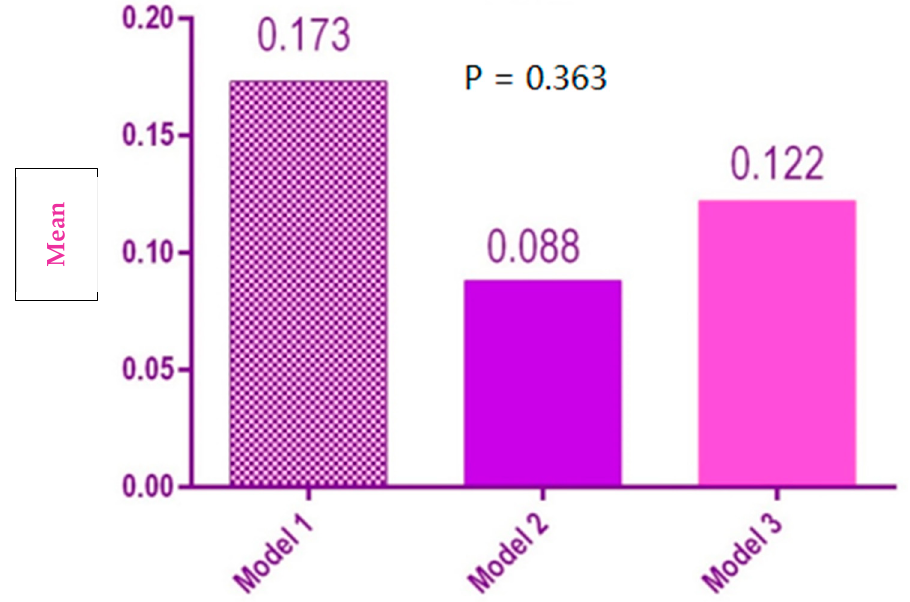
Figure 10. Statistical results of the inner arch distances of the 3 models. There was a significant difference between the mesial-distal width of the three groups, Model 1 having the mean mesial-distal width that was significantly higher than Model 2 and Model 3 (Figure 11).